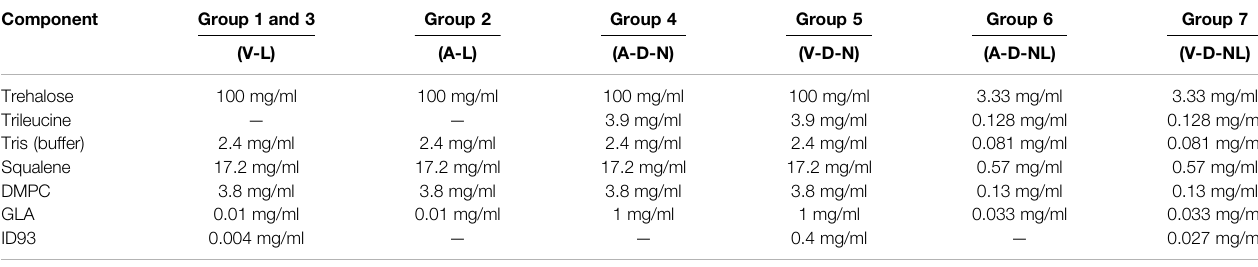
TABLE 2 | Solution preparation for manufacture of each experimental group composition. Nomenclature: V – Vaccine; A – Adjuvant; L – Liquid; D – Dry powder; N – Nose; NL – Nose and Lung. Component